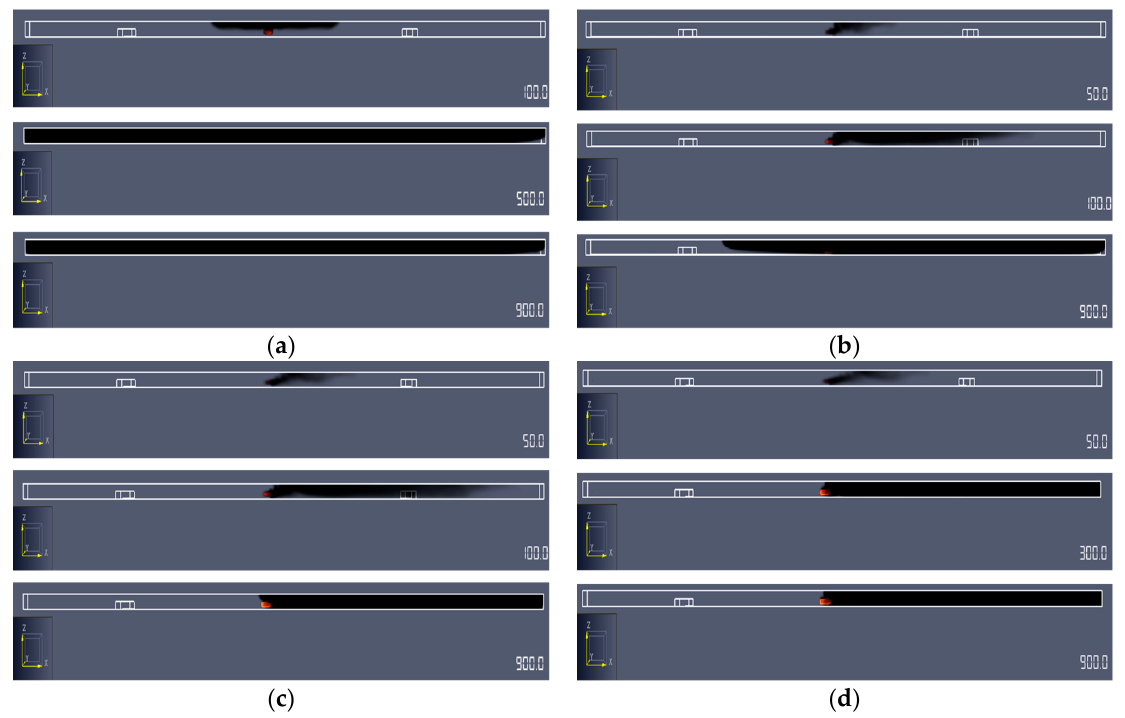
Figure 4. Front view of flue gas development with different longitudinal ventilation